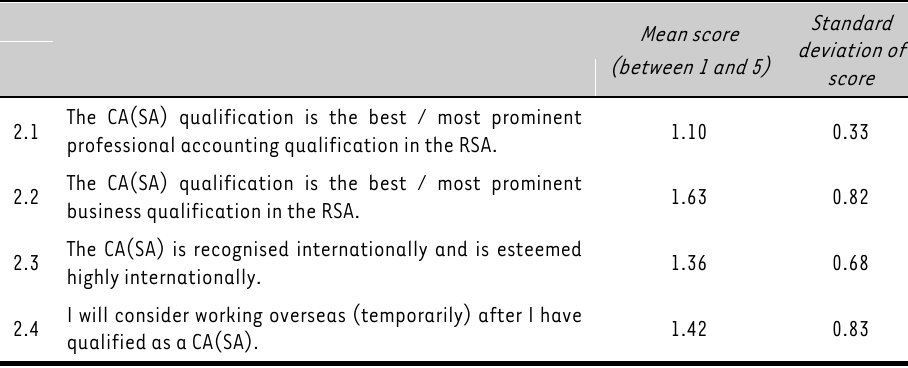
Perceptions regarding the value of the CA(SA) qualification